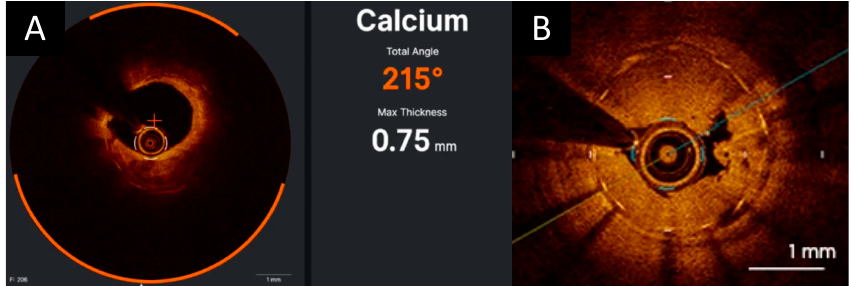
Figure 4. In-stent restenosis (ISR, panel A ) and stent thrombosis (ST, panel B ).